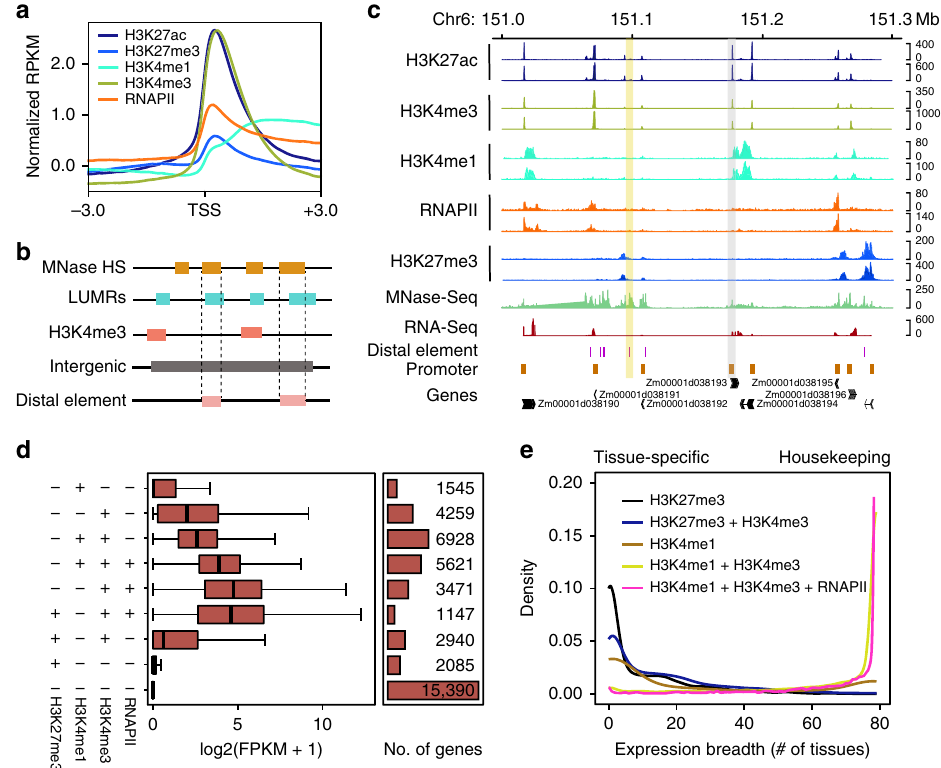
Fig. 1 The epigenome map of maize seedlings. a Distribution of RNA polymerase II (RNAPII) occupancy and H3K4me3, H3K4me1, H3K27me3, and H3K27ac histone modi fi cations at transcription start sites. b Illustration of candidate distal elements (MNase HS, MNase sequencing peak; LUMRs, low and unmethylated methylation regions). c RNAPII occupancy and H3K4me3, H3K4me1, H3K27me3, H3K27ac pro fi les on chromosome 6 (151 – 151.3 Mb). A promoter (gray shading) and a distal element (yellow shading) were highlighted in the region. d Gene expression levels corresponding to different combinations of RNAPII and histone modi fi cations. Boxplots show the median, and third and fi rst quartiles. The whiskers are de fi ned as 0.25 – 1.5 IQR/0.75 + 1.5 IQR, IQR is interquartile range. e Expression breadth analysis of genes with different combinations of RNAPII and histone modi fi cations. Source Data underlying ( d , e ) are provided in a Source Data fi